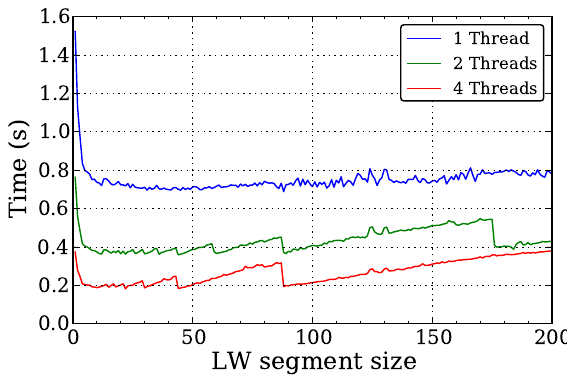
Figure 4. Variation in the time taken to complete the long-wave radiation calculation as a function of segment size for, from top to bottom, 1 (blue line), 2 (green line) and 4 (red line) threads.